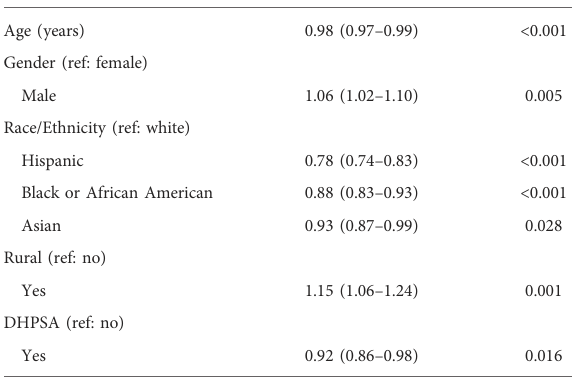
Covariate “ high poverty ” excluded from model after backward variable